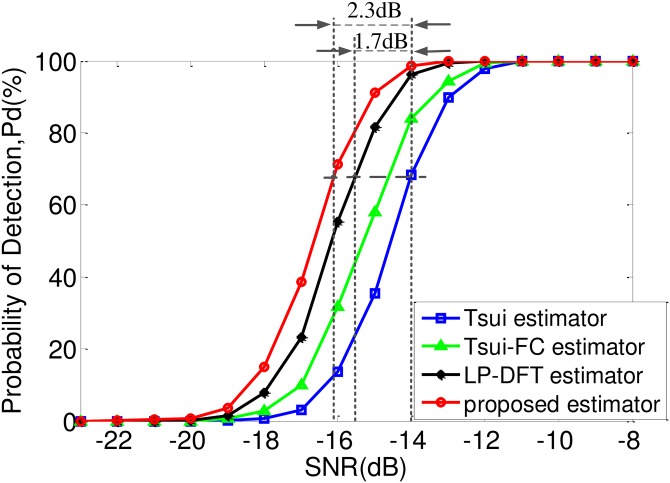
Detection probability curves of different CRT-based estimators.